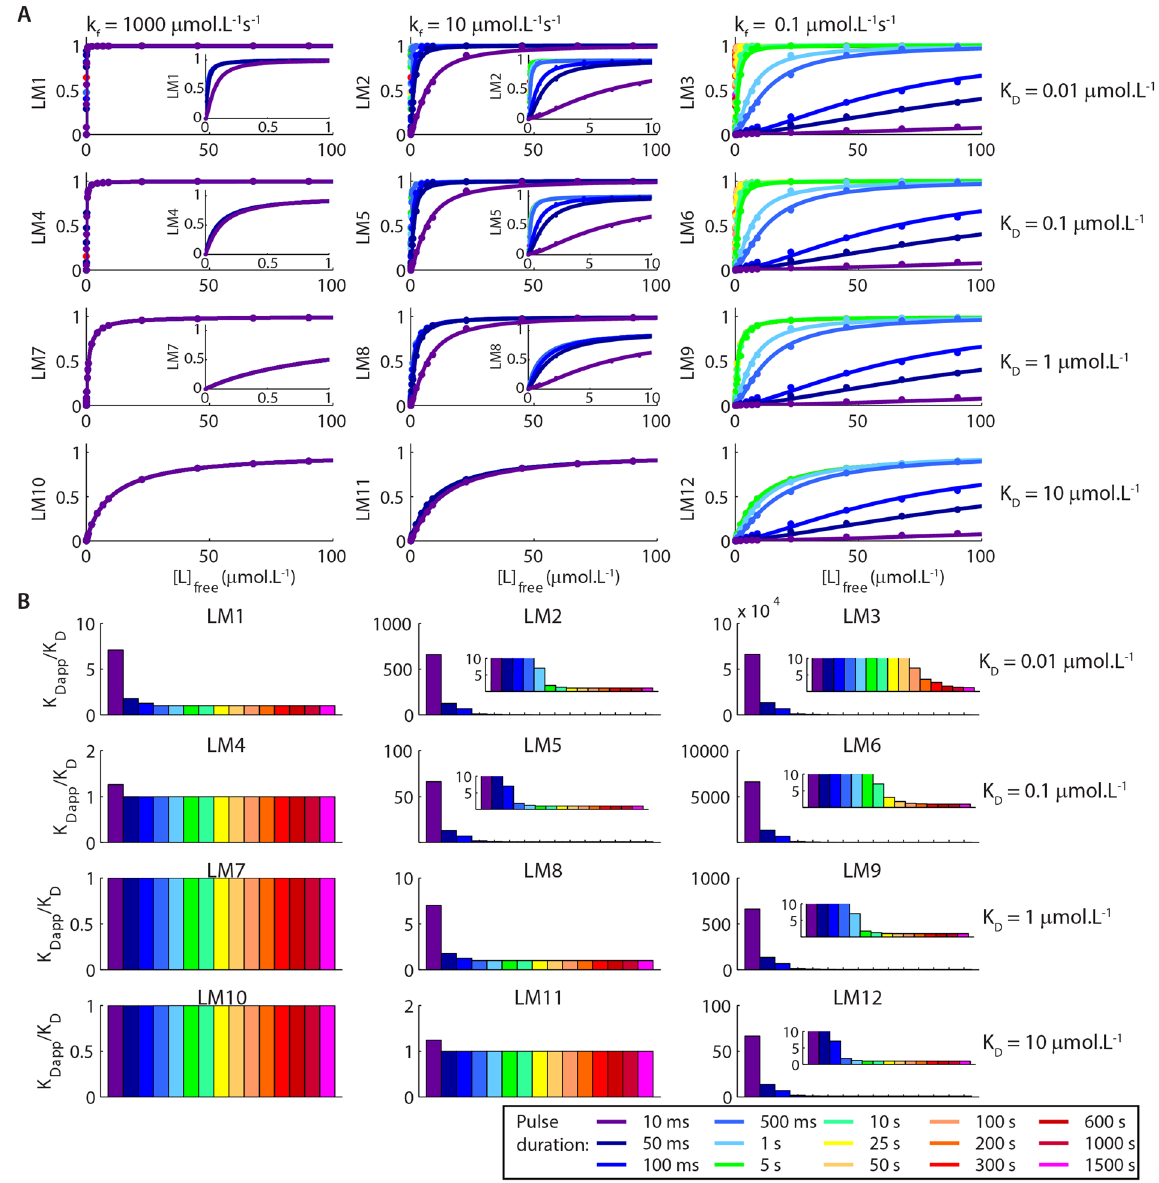
Figure 3. Activations of LM1-LM12 for pulses of [L] free with different durations and concentrations. ( A ) Dose- response curves for the formations of LM1-LM12 as functions of pulses of [L] free with different durations. ( B ) K Dapp /K D ratios calculated using the K D s showed in Fig. 1C and the K Dapp s (Suppl. Table S1) obtained from the curves showed in A . The control K D s for the interaction of each molecule with L are showed on the right of the panels and the k f s for the association reactions are indicated on the top of A . The k b for each reaction is calculated by: . The insets show the same results in a different scale for better visualization. The D legend indicates the colour code used to represent each duration of [L] free